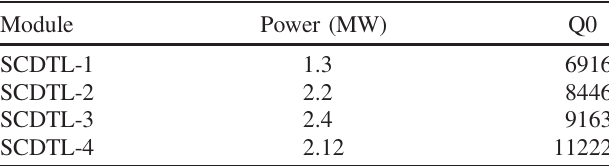
TABLE IV. Average on field pick-up value for the four SCDTL structures and relative error.